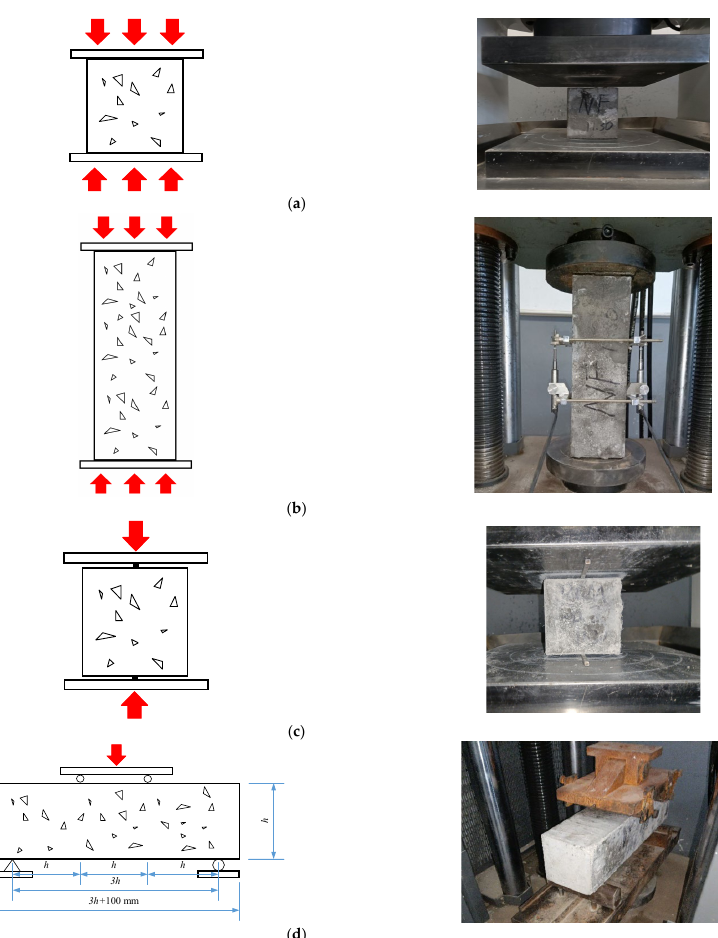
Figure 4. Mechanical performance tests: ( a ) cube compressive test; ( b ) axial compressive test; ( c ) splitting tensile test; ( d ) flexural test.